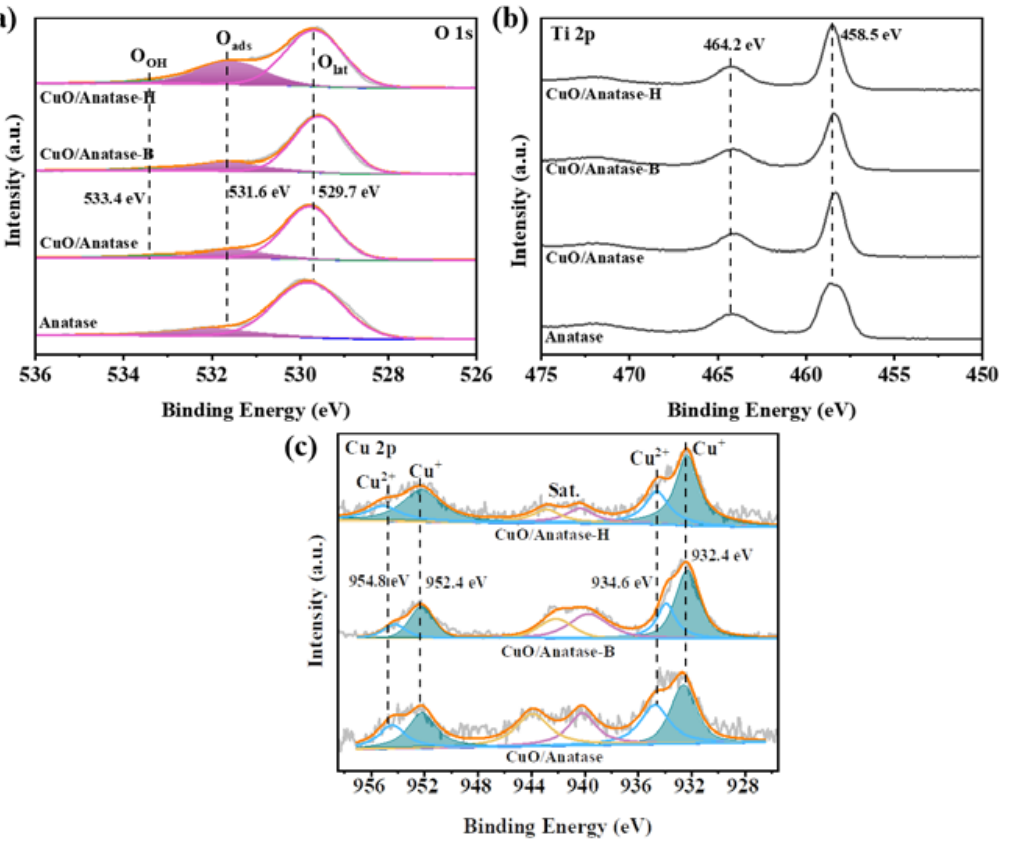
Figure 5. XPS of ( a ) O 1s, ( b ) Ti 3p and ( c ) Cu 2p of anatase, CuO/anatase, CuO/anatase-B and CuO/anatase-H catalysts. Table 2. Surface compositions of the catalysts.